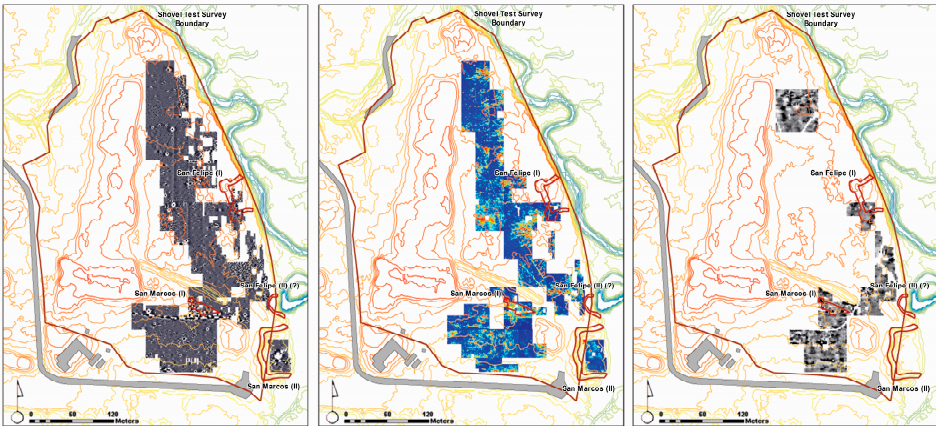
Figure 4. Maps showing the coverage of each geophysical survey method. From left to right: magnetic gradiometry, ground penetrating radar, and electrical resistivity. Contour spacing is 1 m. Contours are based on the LiDAR dataset and use the NAD 1983 and NAV 1988 horizontal and vertical datum, respectively.